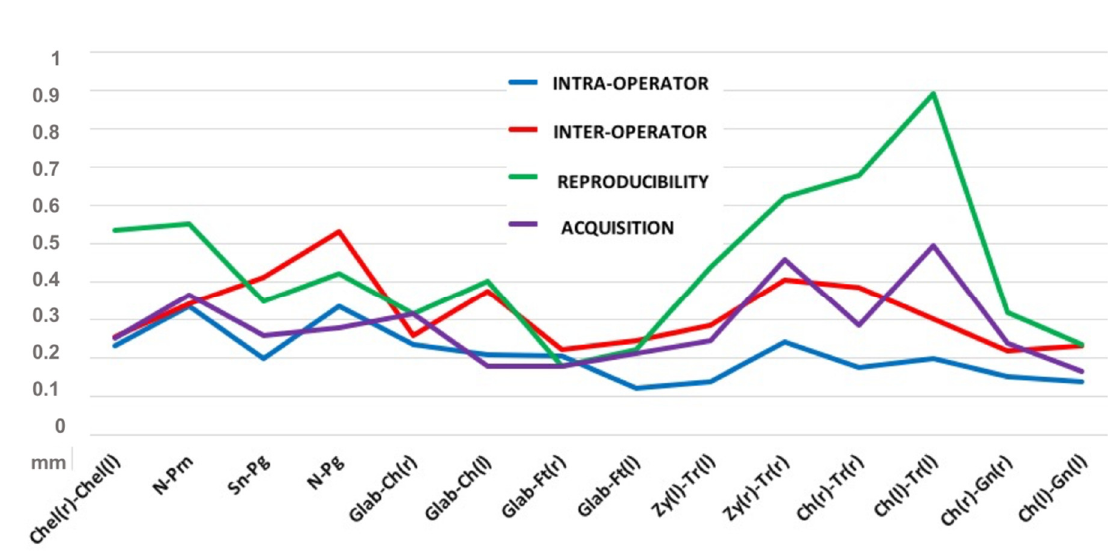
Figure 3. Maximum error distribution (mm).